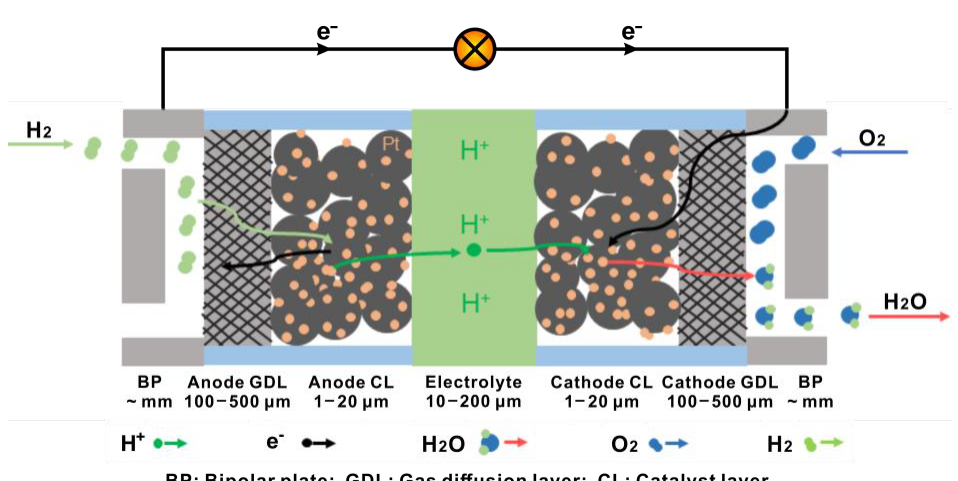
Figure 1. Schematic diagram of the structure of a PEMFC.